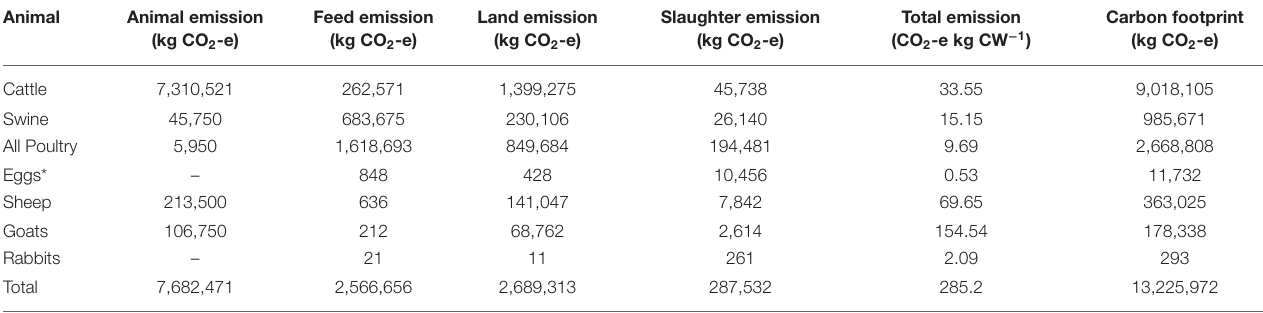
TABLE 2 | Overall farm emissions by animal species.